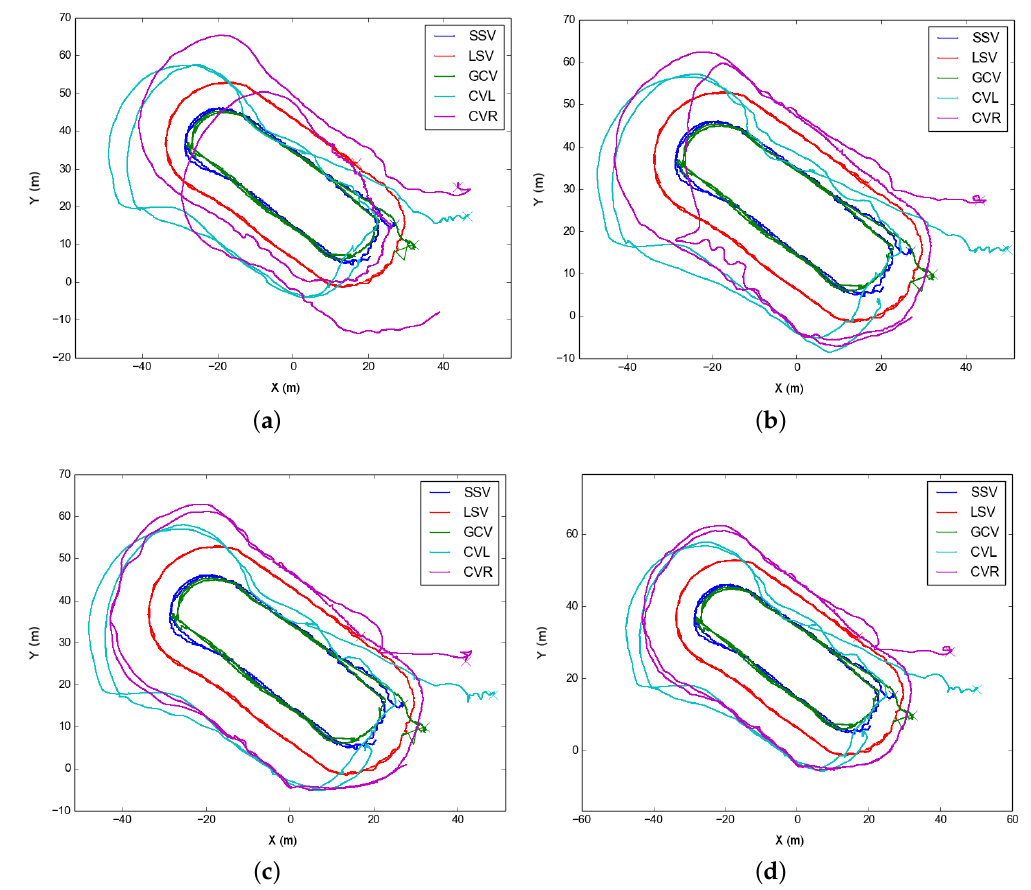
Figure 8. Different trajectories for the Morph Horta dataset at the 9th of September 2015. We show on ( a ) the dead reckoning trajectories of each vehicle; Then, on ( b , c ) we can observe the results of optimizing using just ranges or USBL measures respectively; Finally, on ( d ), we show the resulting optimized trajectories accounting for both